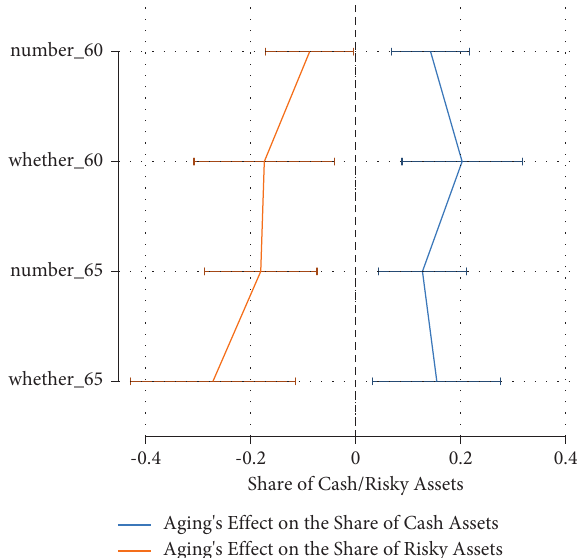
Figure 3: Point estimates and 95% confidence intervals of aging’s effects on the share of cash and risky